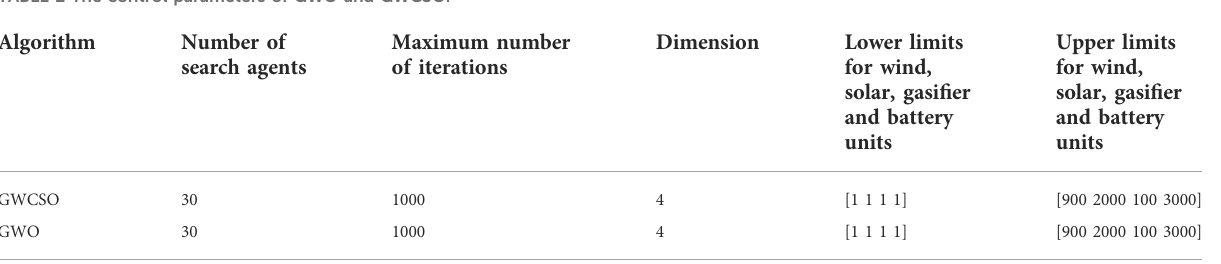
TABLE 2 The control parameters of GWO and GWCSO.